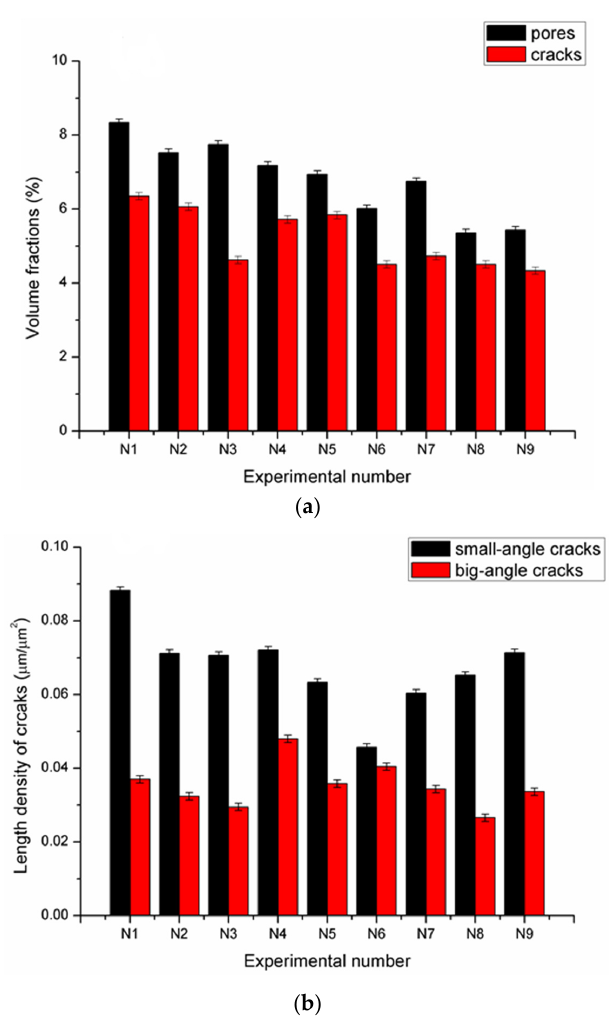
Figure 4. ( a ) Volume fractions of pores and cracks ( b ) length density of cracks.